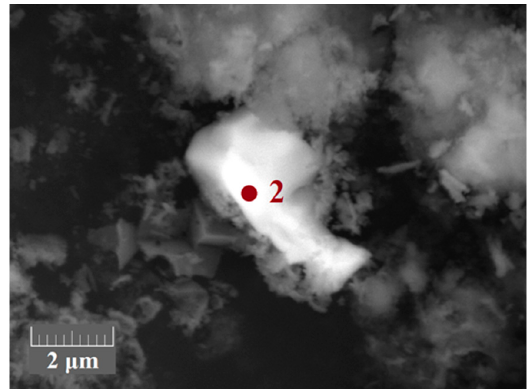
Figure 11. SEM image of an area in the solid residue obtained by the leaching of the SSAT sample using 10% HCl at 170 °C and S:L ratio = 1:11 for 60 min. The composition of the point 2 is given in Table 5. Table 5. Elemental composition (at.%) of the sample point signed in Figure 11.